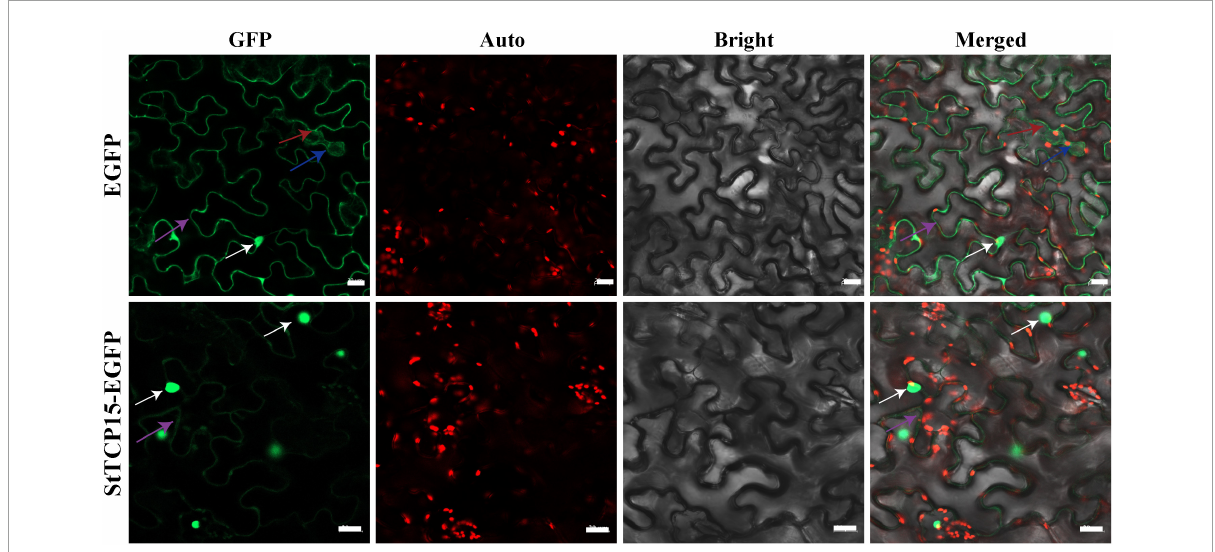
FIGURE2 Subcellular localization of StTCP15 protein in Nicotiana benthamiana leaf cells. The EGFP and StTCP15-EGFP fusion protein transiently expressed in tobacco. The white arrows indicate the nucleus, blue arrows indicate cytoplasm, purple arrows indicate cytoplasmic membrane, and red arrows indicate chloroplasts. GFP: EGFP fluorescence signal in the dark field; Auto: Autofluorescence of chlorophyll; Bright: Cell morphology under bright field; Merged: Combination field. The scale bale represents 20 µ m.